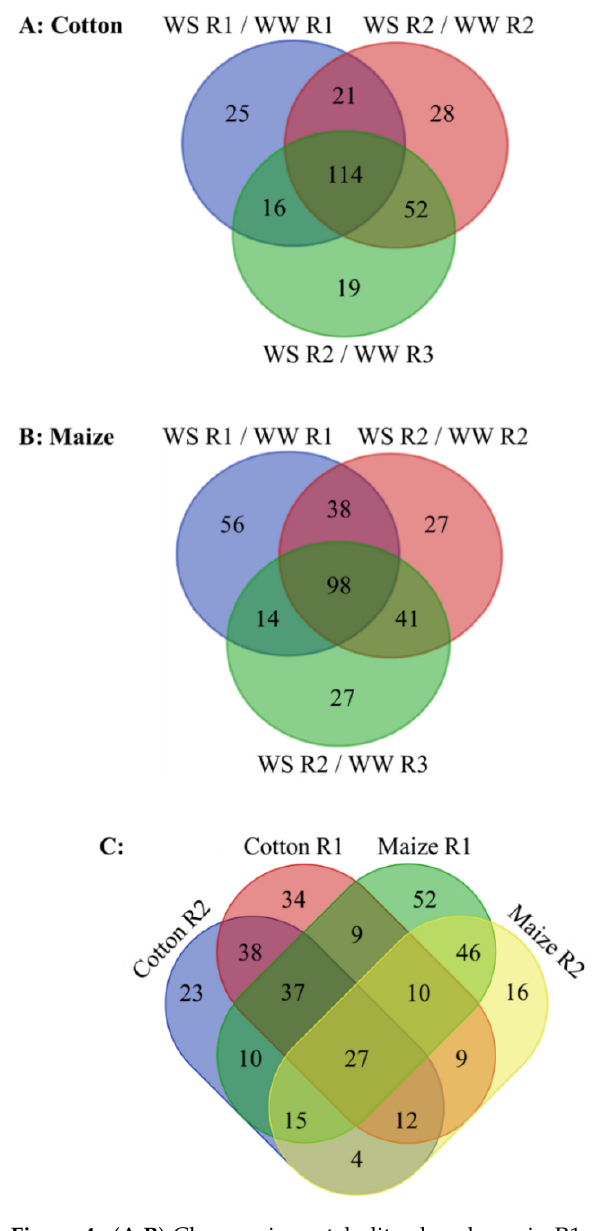
Figure 4. ( A , B ) Changes in metabolite abundance in R1 and R2 of the elongation zone of water- stressed (WS) compared with well-watered (WW) cotton and maize primary roots. Changes in water-stressed R2 are also compared with well-watered R3 to help distinguish changes associated with water stress-induced growth inhibition from those associated with cell maturation (see text for details of this analysis). In the water stress treatments, vermiculite water potentials were − 1.0 MPa (cotton) and − 1.6 MPa (maize), which resulted in equivalent root tip water potentials in the two species (Figure 2). ( C ) Comparison of water stress-induced changes in metabolite abundance